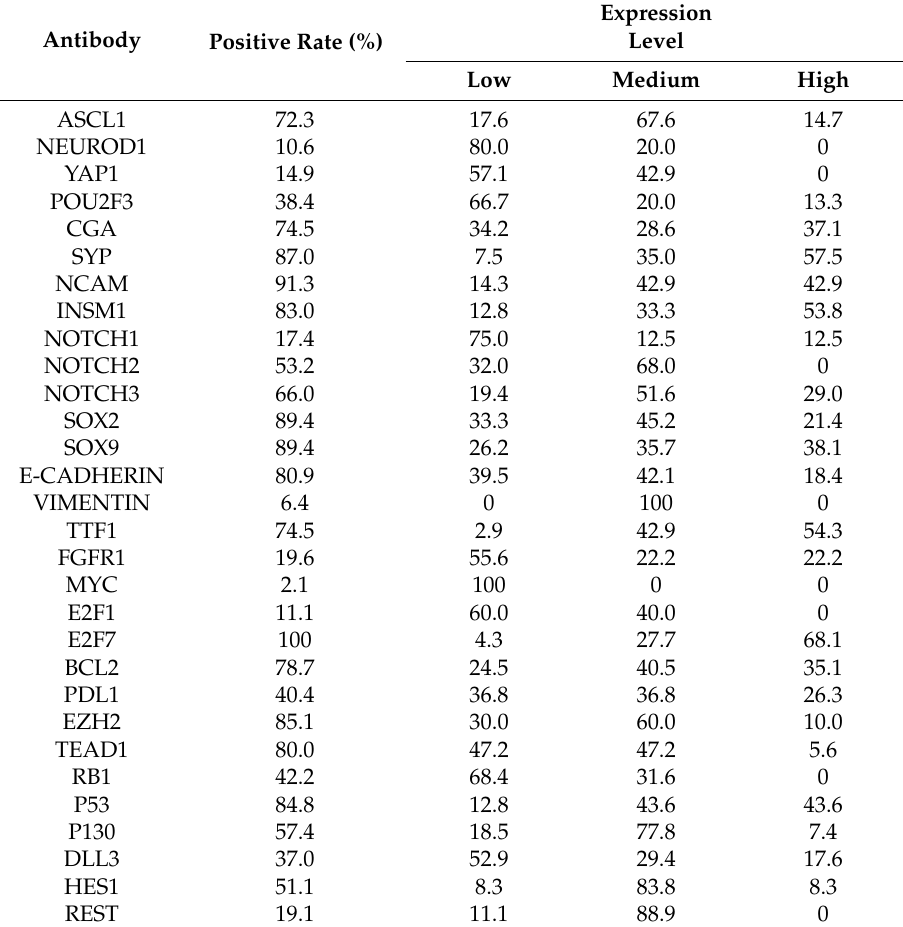
Table 2. Immunohistochemical results in